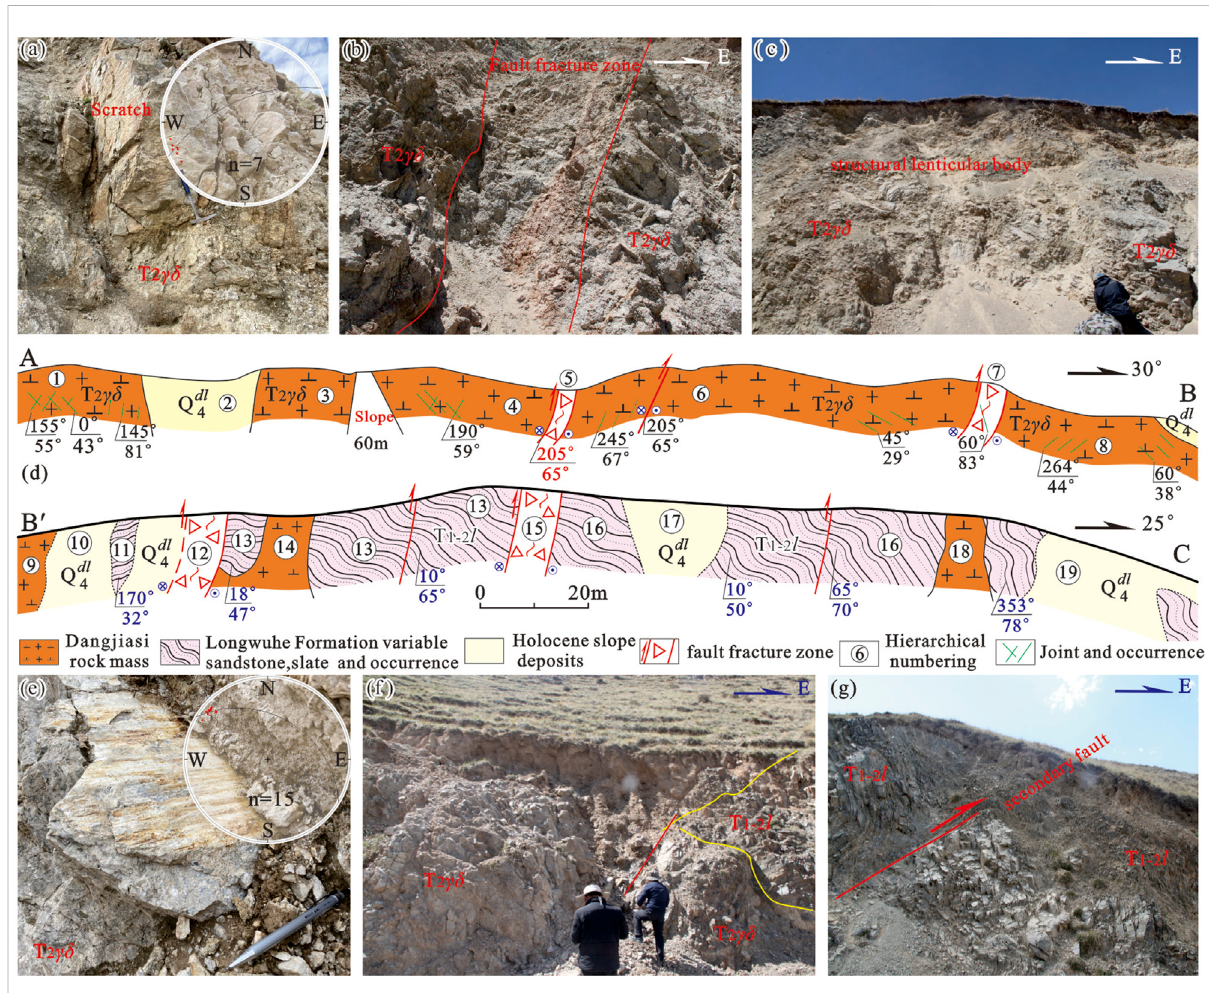
FIGURE 3 Measured structural pro fi le along the road paralleling Waliguan relay station ’ s eastern foot. (d) Coordinate of starting point A: E100 ° 53 ′ 56 ″ , N36 ° 17 ′ 28 ″ ; coordinate of end point B: E100 ° 53 ′ 56 ″ , N36 ° 17 ′ 28 ″ ; coordinate of starting point B ′ : E100 ° 53 ′ 65 ″ , N36 ° 17 ′ 33 ″ ; coordinate of end point C: E100 ° 53 ′ 59 ″ , N36 ° 17 ′ 40 ″